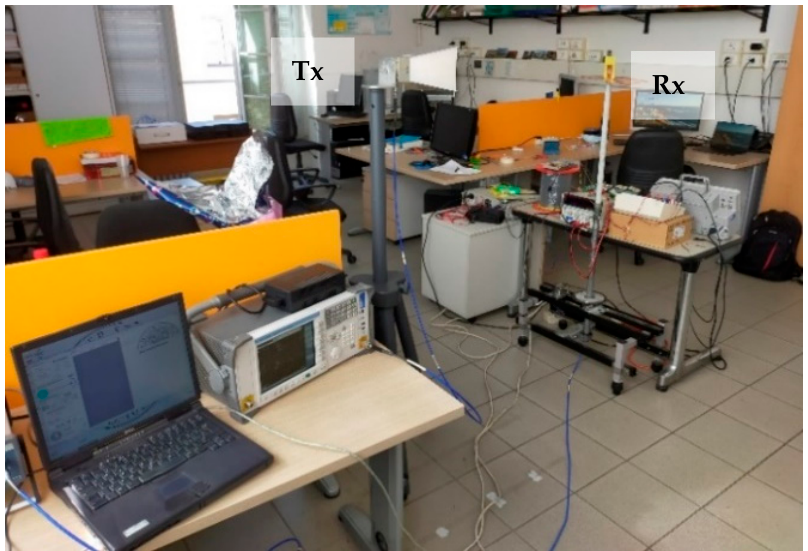
Figure 22. Experimental measurement setup at DEI laboratory.